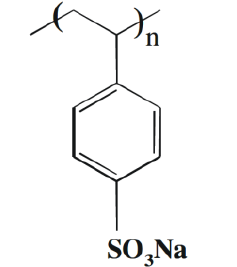
Figure 1. Monomer unit of Sodium Polystyrene Sulfonate